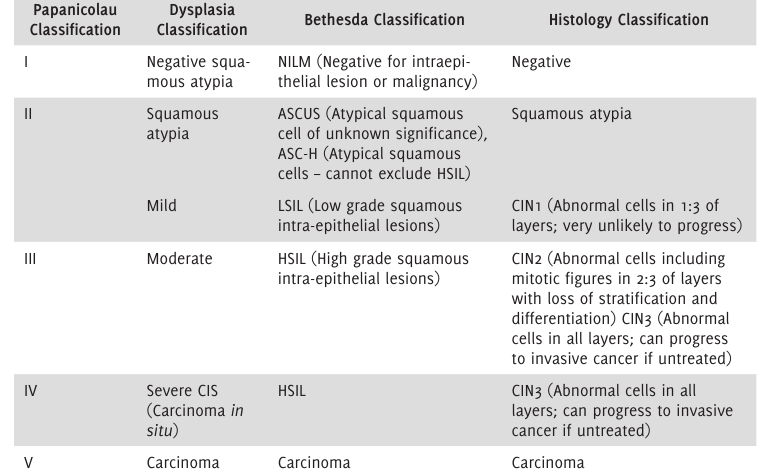
Table 2. Classification of Cervical Intraepithelial Lesions Papanicolau